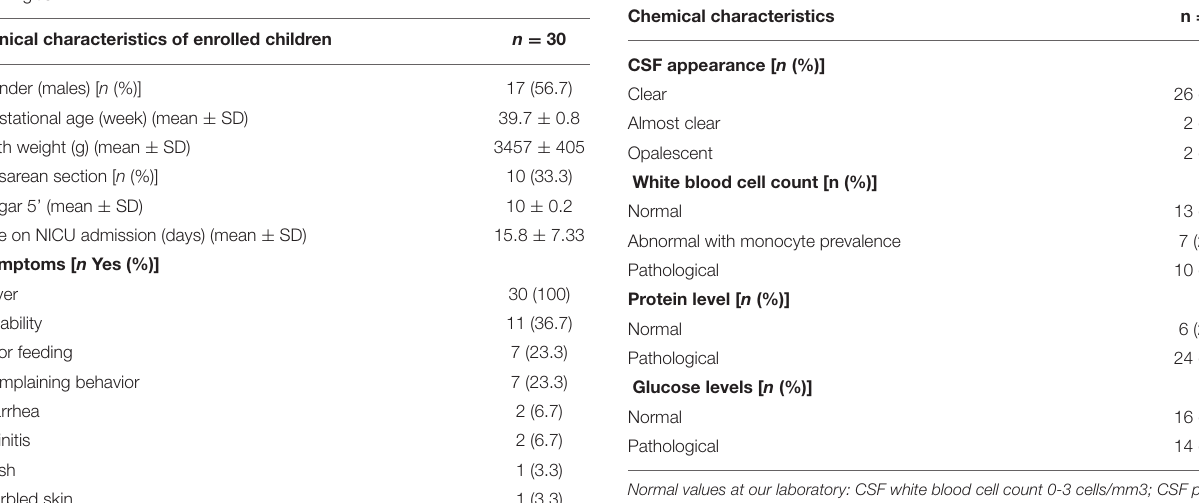
TABLE 1 | Clinical characteristics and length of hospital stay of neonates with viral meningitis. Clinical characteristics of enrolled children